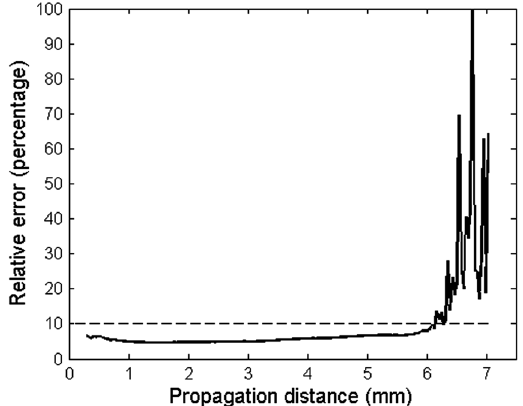
FIG. 6. Normalized root mean square error (NRMSE) between measured and actual values from the simulation, shown in percentage. The NRMSE values were calculated from the position − 50 μ m to 50 μ m relative to the probe ’ s